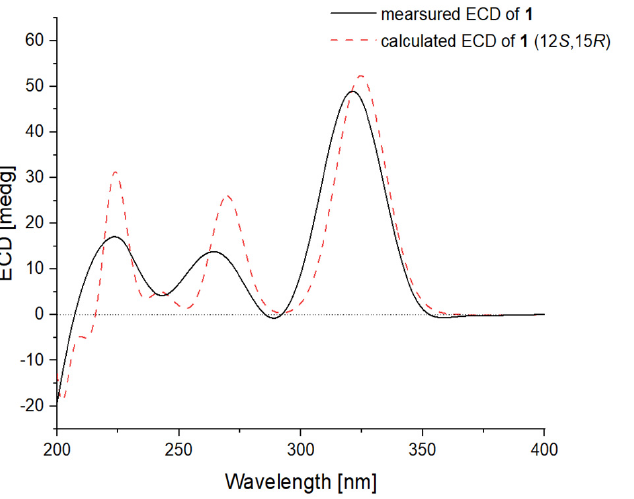
Figure 3. Key NOESY correlations of compounds 1 – 4 and 6 .